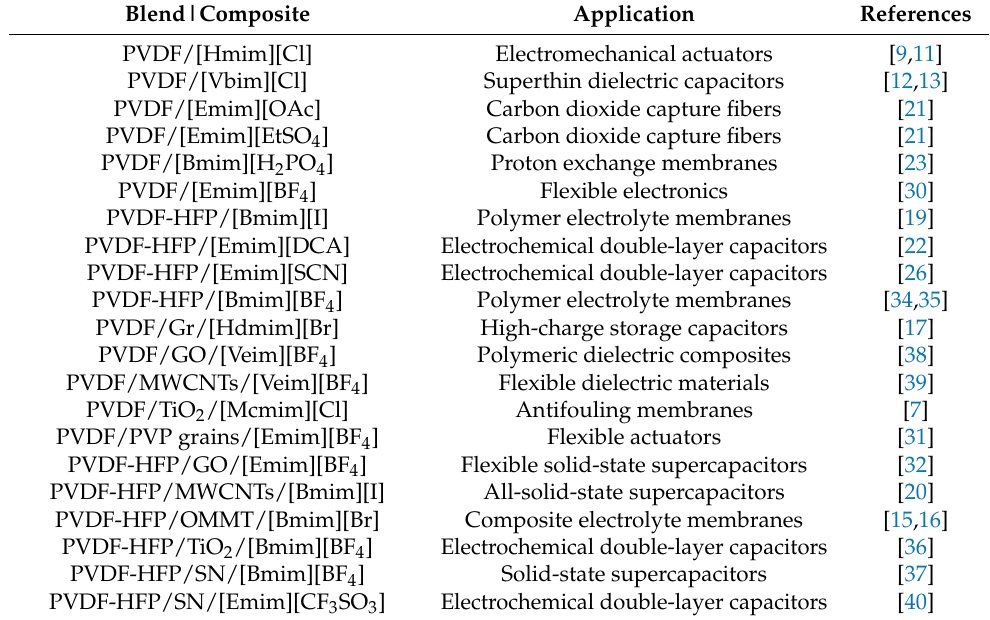
Table 9. Applications of PVDF/and PVDF-HFP/hydrophilic imidazolium-based ionic liquid blends and